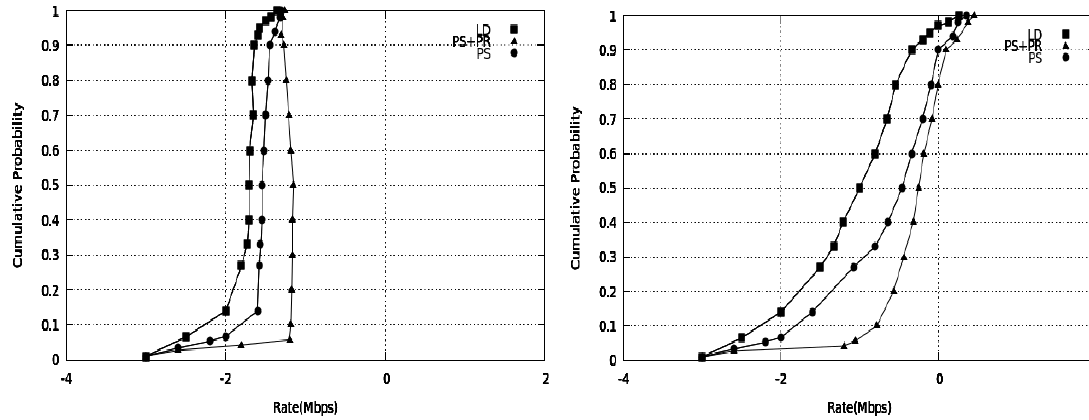
Figure 4. Throughput dissemination among schemes having varied road scenario 𝑵